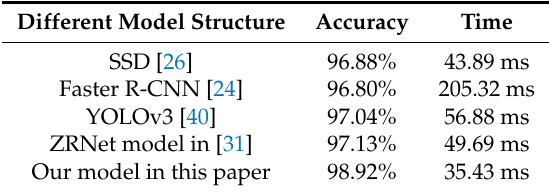
Table 5. Results of comparative